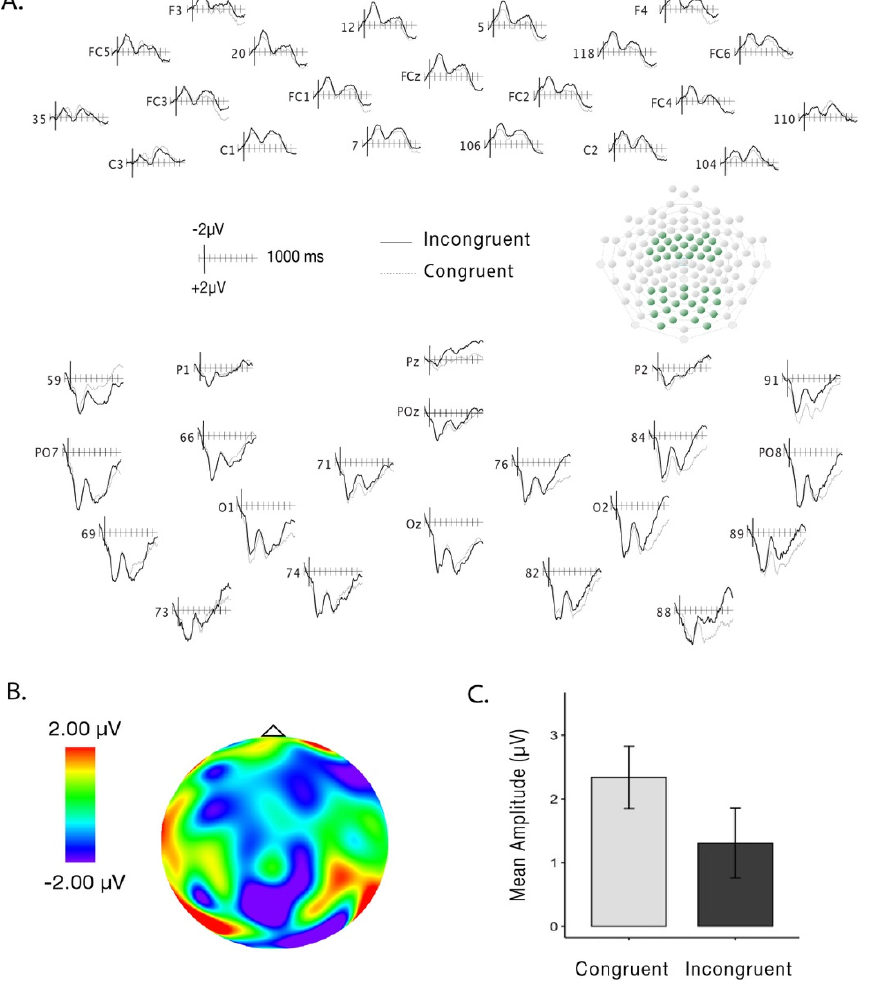
Figure 2. ( A ) Grand-averaged waveforms for congruent (dashed lines) and incongruent trials (solid lines) over the frontal and parietal-occipital areas over the late time-window. ( B ) Difference wave (incongruent-congruent) topographical map displaying activity over the late time-window. ( C ) Mean amplitudes across frontal and parietal-occipital areas for congruent and incongruent trials in the late time-window. Error bars represent standard error from the mean.